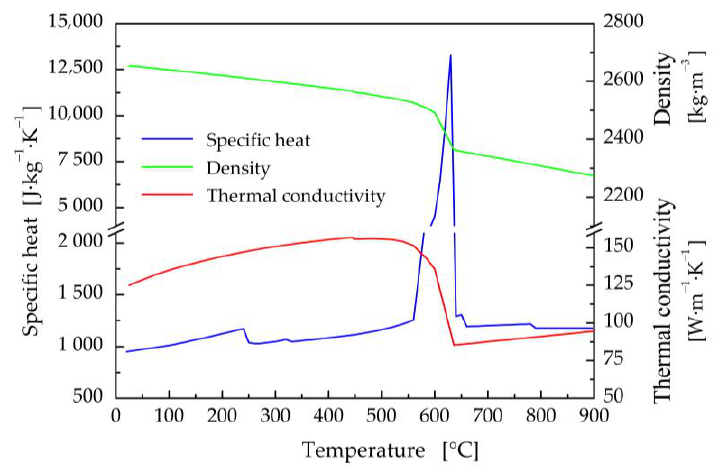
Figure 4. Thermal properties of the filler material 5087 in dependence on temperature.